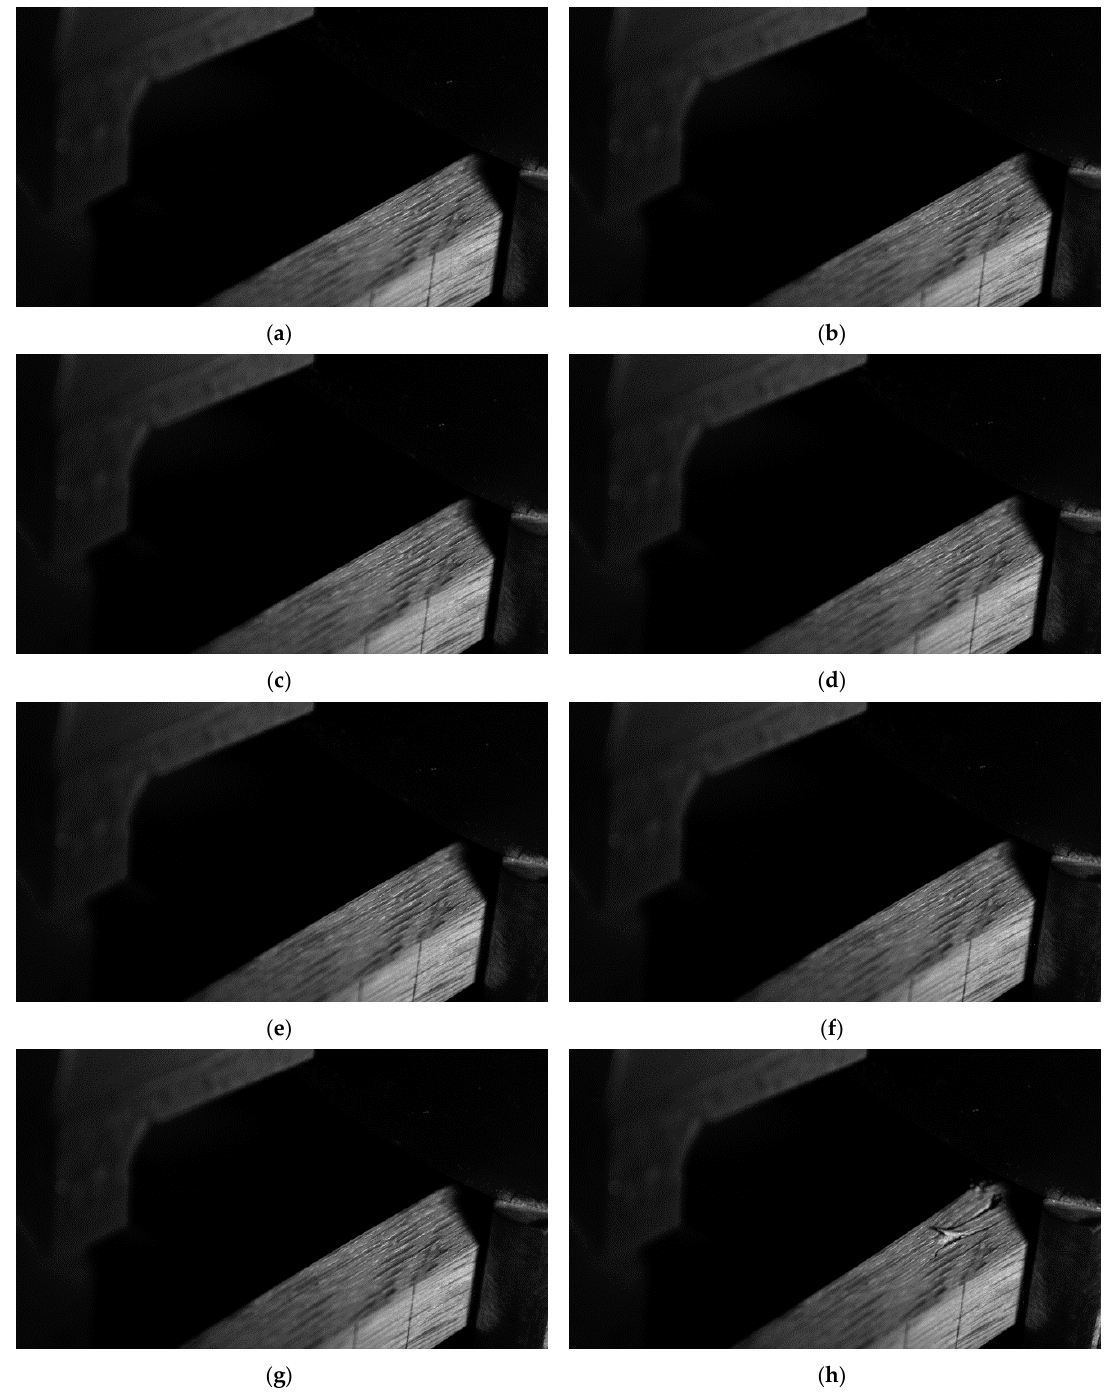
Figure 10. Time course of impact bending strength test for oak wood: 0 ms ( a ), 0.31 ms ( b ), 0.62 ms ( c ), 0.93 ms ( d ), 1.24 ms ( e ), 1.55 ms ( f ), 1.86 ms ( g ) and 2.17 ms ( h ).